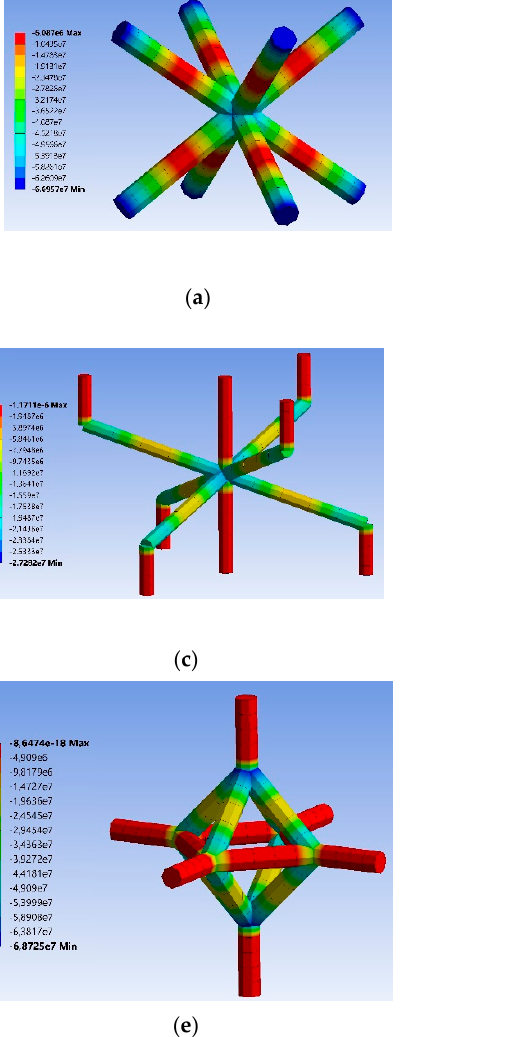
Figure A4. Bending stress of unit cells: ( a ) BCC; ( b ) diamond; ( c ) hexagonal packing; ( d ) rhombicuboctahedron; ( e ) truncated cube; and ( f ) truncated octahedron in ANSYS.